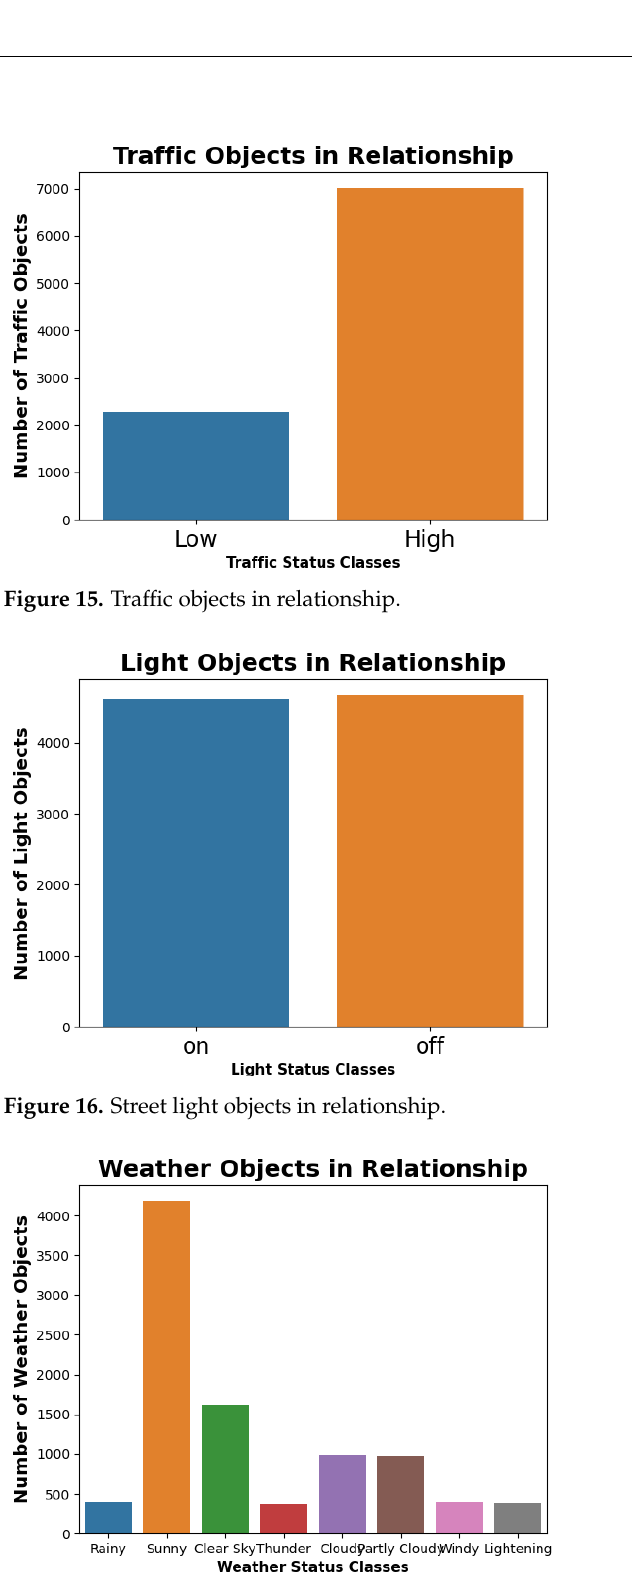
Figure 17. Weather objects in